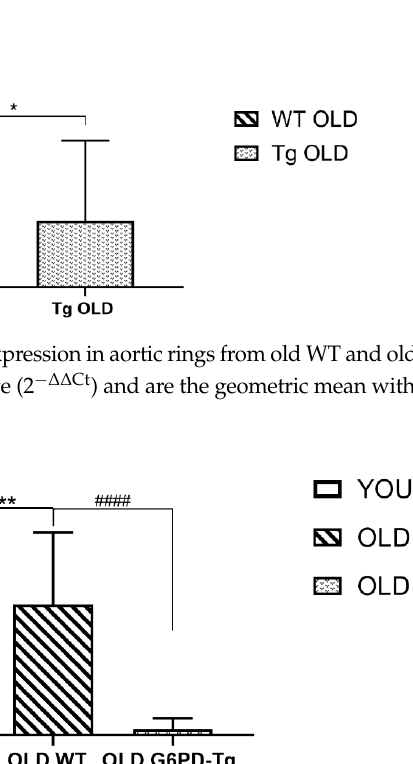
Figure 1. Maximal endothelium-dependent vasorelaxation in response to acetylcholine for all groups (Panel A ) and preincubated with L-arginine 10 − 3 M and nor-NOHA 10 −5 M in young WT, old WT and old G6PD-Tg (Panel B – D ) in aortic rings. Results are expressed as % relaxation of acetyl- choline 10 − 6 M and are the mean ± SD ( n = 5 – 10 per group). ** p < 0.01 and * p < 0.05.